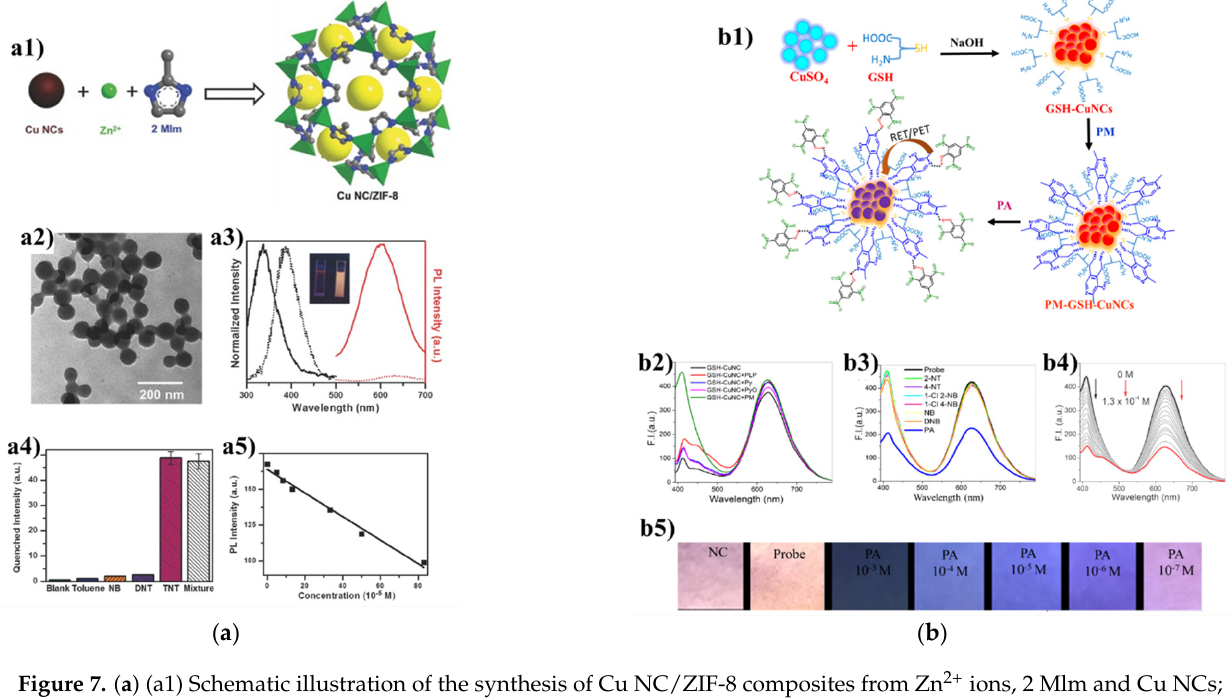
Figure 7. ( a ) (a1) Schematic illustration of the synthesis of Cu NC/ZIF-8 composites from Zn 2+ ions, 2 Mlm and Cu NCs; (a2) TEM images of Cu NC/ZIF-8 composites; (a3) PL (red, excited at 365 nm) and PLE (black, detection wavelength 600 nm) spectra of Cu NCs (dotted lines) and Cu NC/ZIF-8 composites (solid lines); (a4) the decrease in PL intensity of Cu NC/ZIF-8 composites to blank, toluene, NB, DNT, TNT, and the mixture of all above (concentration of all compounds 500 × 10 − 6 M); (a5) Linear relationship between the PL intensity of Cu NC/ZIF-8 composites and the concentration of TNT; ( b ) (b1) Schematic representation for the synthesis of GSH-CuNCs and its interaction with PM and followed by with PA; (b2) fluorescent spectral changes of GSH-CuNCs upon addition of various vitamin B6 cofactors; (b3) fluorescence spectral changes of PM-GSH-CuNCs in the presence of various nitro-aromatics; (b4) fluorescence spectral changes of PM-GSH-CuNCs upon addition of increasing [PA]; (b5) fluorescence color changes of the modified paper strips upon interaction with different concentrations of PA (1 mM to 10 − 7 M) observed under UV light at 365 nm. Table 4. List of fluorescent probes based on Cu NCs for detection of other analytes.